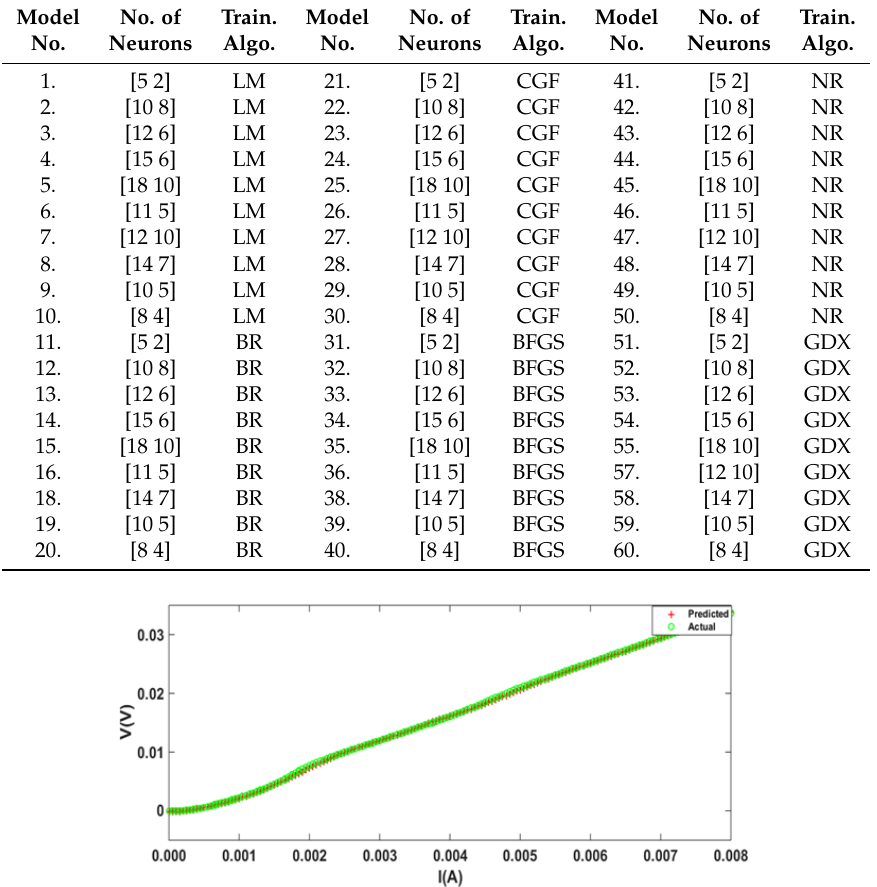
Figure 4. Actual vs. predicted IV curves for temperature = 8.5 K, magnetic field = 300